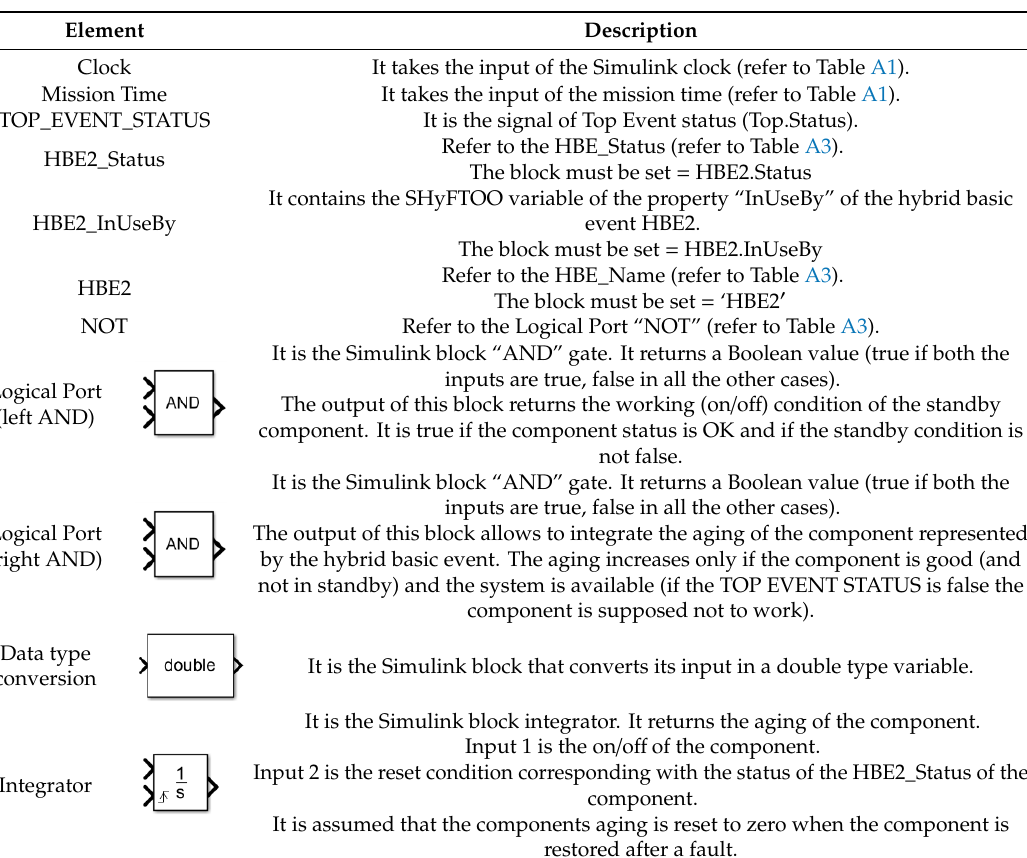
Figure A6. Block Parameters for the variables ( a ) QI and ( b ) % particle. Table A9. Marking of the components of the hybrid basic events HBE6 (referring to Figure 6).